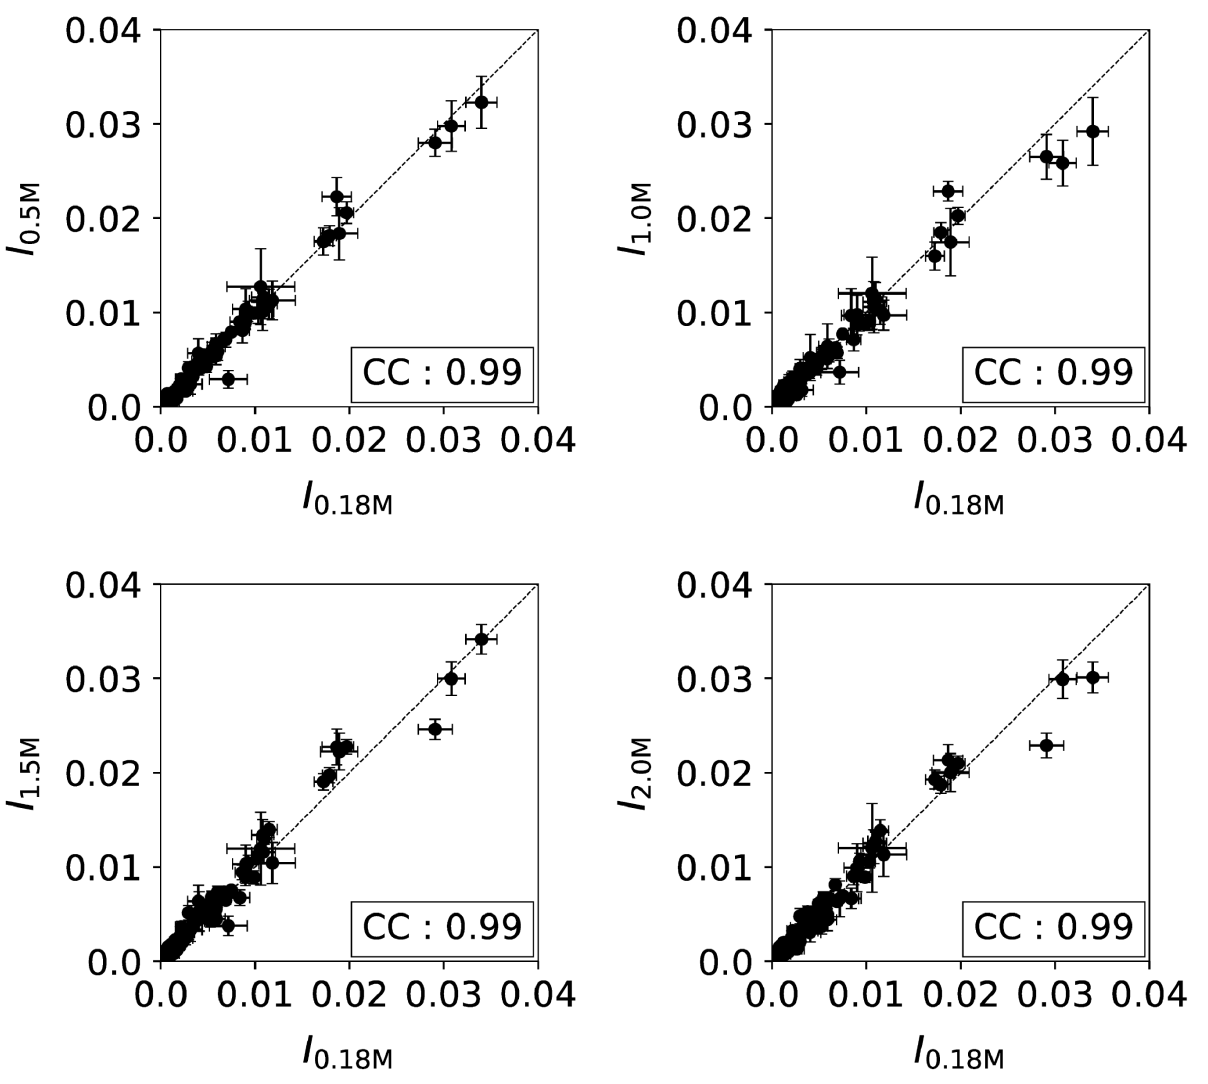
Fig 2. Comparison of PhAST signals in free DNA at various ionic strengths. The Phast signal is expressed in terms of intensity (I) that is the normalised peak height associated with each YpY step of the free 601 sequence. The data collected at 0.5, 1.0, 1.5 and 2 M NaCl were systematically compared to those at 0.18 M NaCl. Each point represents the value of I, averaged from 6 experiments related to assembly and disassembly studies; the vertical and horizontal bars are standard errors. The correlation coefficients (CC) are given in boxes in each panel. https://doi.org/10.1371/journal.pone.0267382.g002 Our procedure maximizes, within the aforementioned constraints, the likelihood of the frag- ment length assignment given its sequence. The resulting sets of peak intensity as a function of DNA sequence for n independent replicates at the same salt concentration were averaged ( n = 3, 4 or 5 depending on the condition), and the standard error was calculated. Quantification of induced DNA structural changes. To quantify changes in the likeli- hood of pyrimidine dimer formation due to histone binding at a given salt concentration, we calculated the ratio between the peak intensity in the sample with DNA and histones (D+H) over the sample with DNA alone (D) for each pyrimidine dinucleotide on both strands. These intensity ratios (IR) indicate how much more or less likely it is for a given pyrimidine dimer to